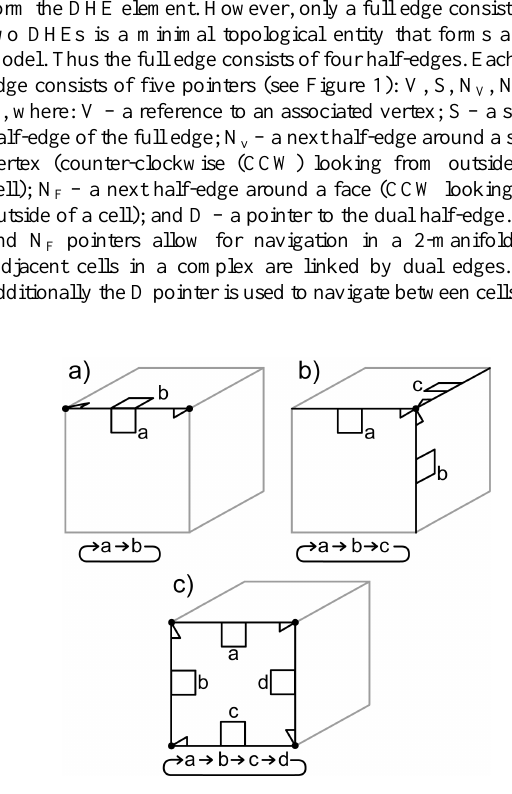
Figure 1. Half-edges in a cell are connected with pointers: a)